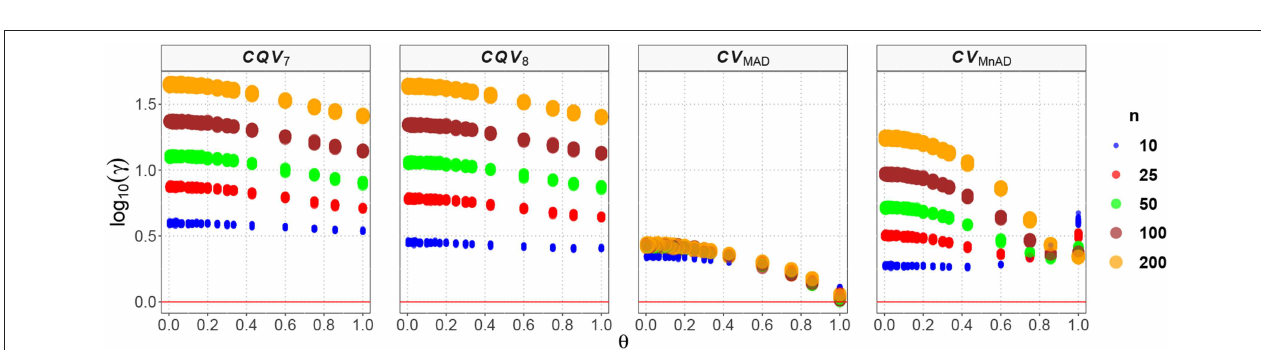
(0,1) produced for each estimator and sample size under the reparametrized ∈